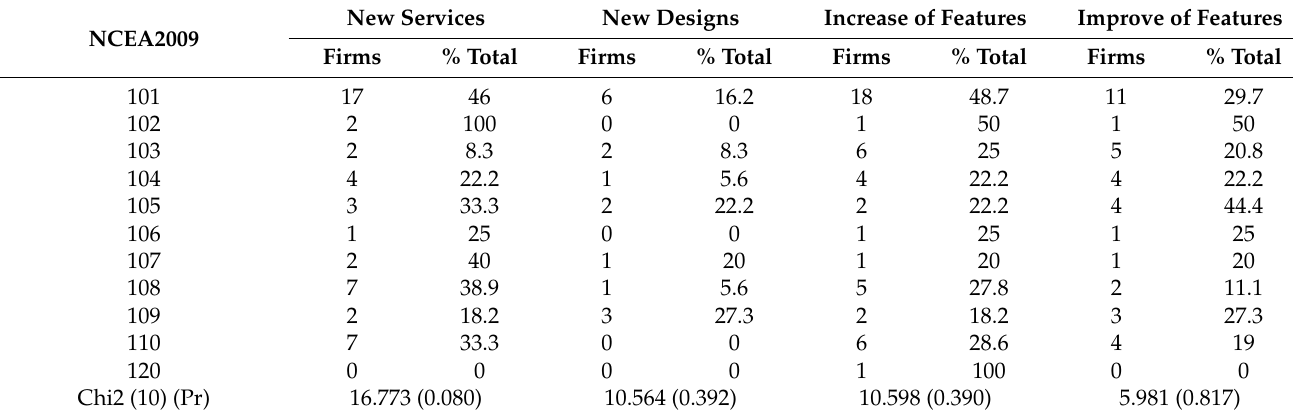
Table 8. Changes made to services according to the branch of activity.